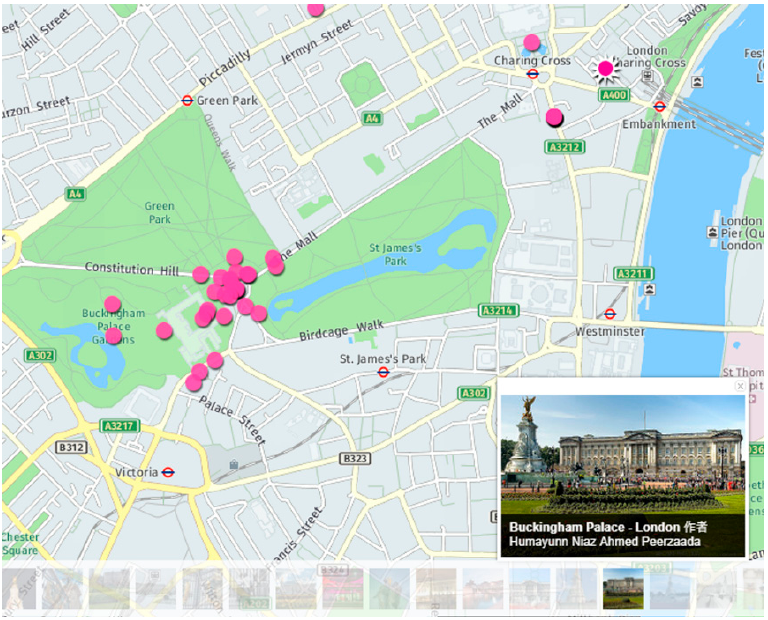
Figure 2. Incorrectly geotagged image.